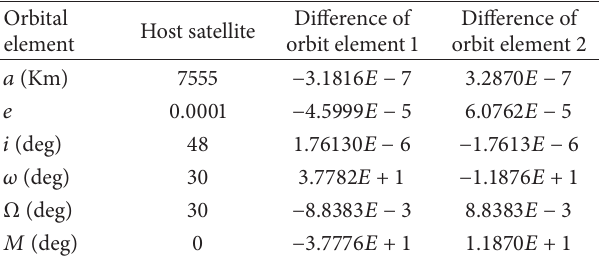
Table 1: Orbit elements of formation flying satellites including several